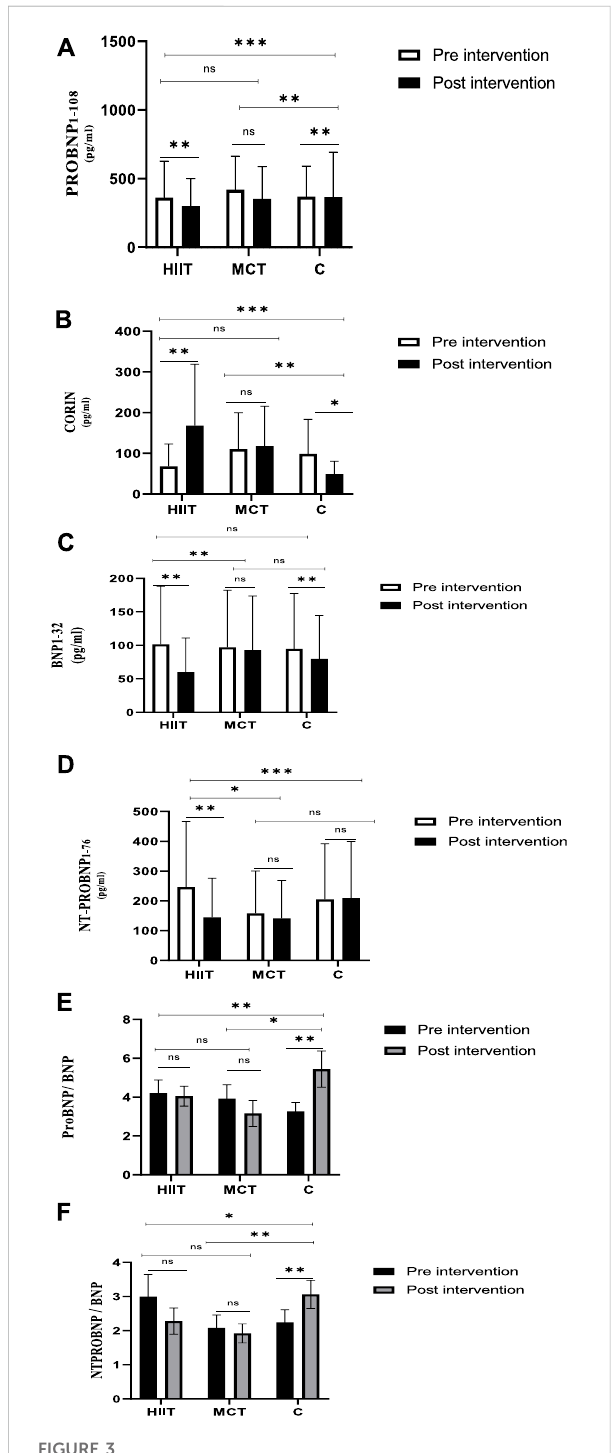
FIGURE 3 The differences in variables from Pre-Intervention to Post- intervention and between-group differences of variables (A) Within and between groups, changes in PROBNP 1-108 . (B) Within and between groups, changes in CORIN. (C) Within and between groups, changes in BNP 1-32 , (D) Within and between groups, changes in NT-PROBNP 1-76 . (E) Within and between groups, changes in ProBNP/BNP ratio. (F) Within and between groups, changes in NTProBNP/BNP